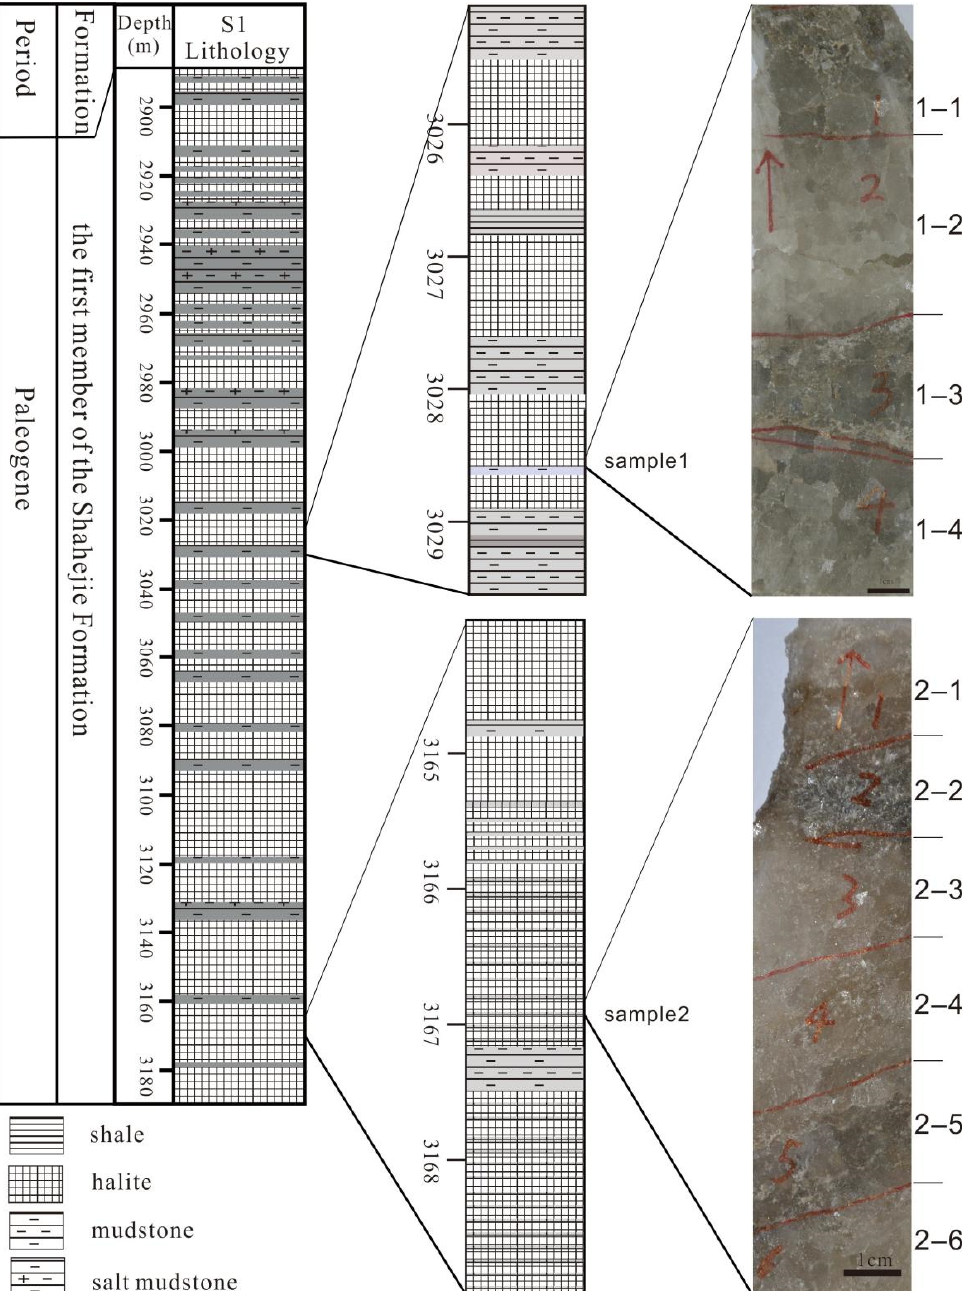
Figure 2. Petrology and sampling location of the studied core S1.